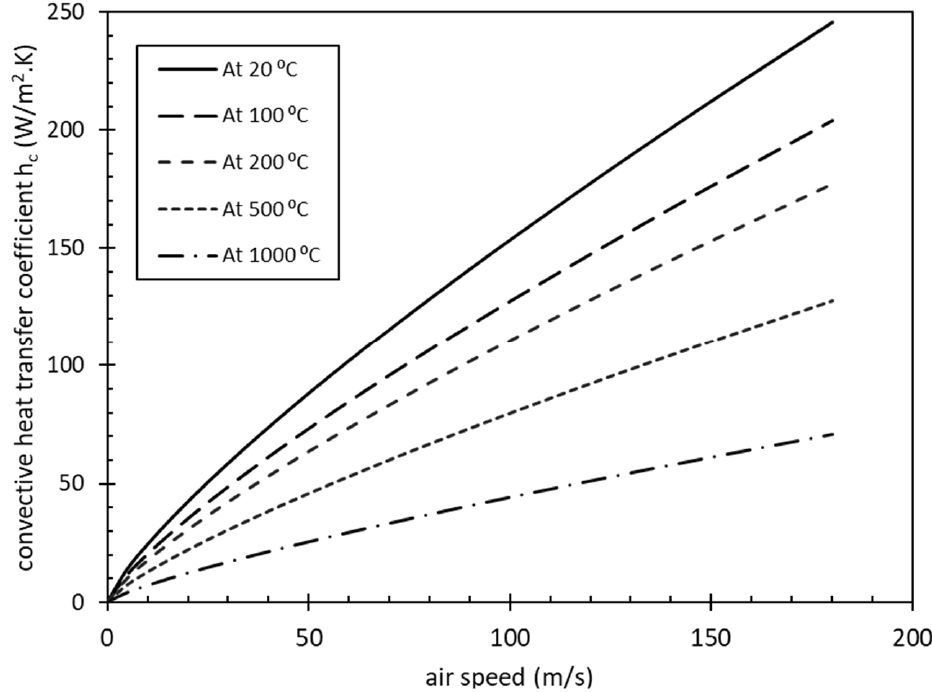
Figure 1. Calculated forced convective heat transfer coefficient at range of temperatures .